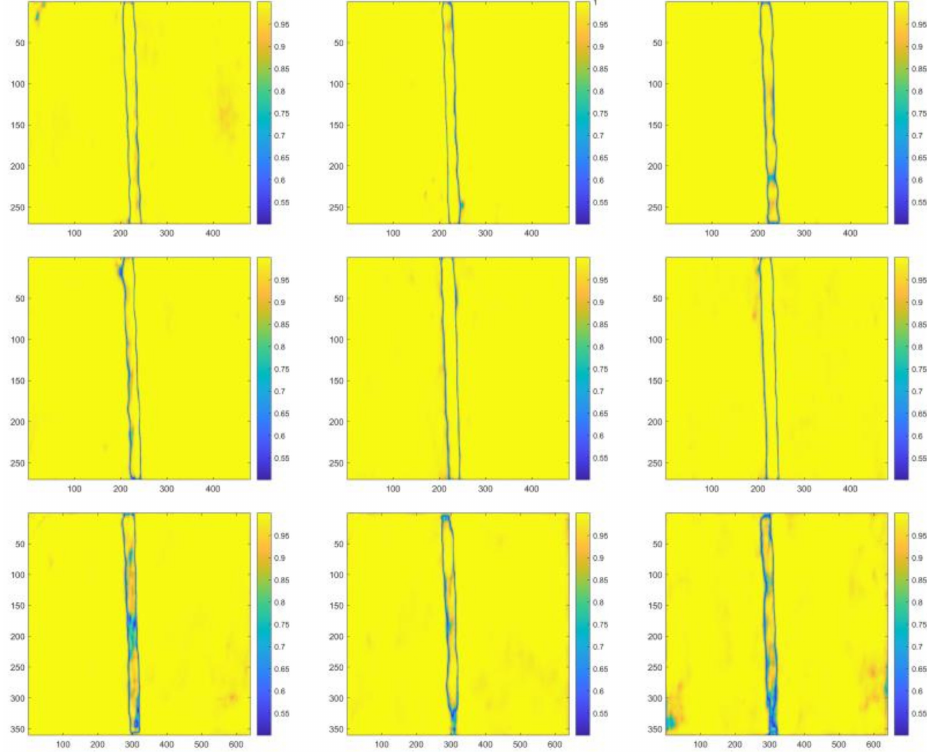
Figure 14. Visualized segmentation results in the heat map form of the same representative testing image with the C-T ratio of 0.04.